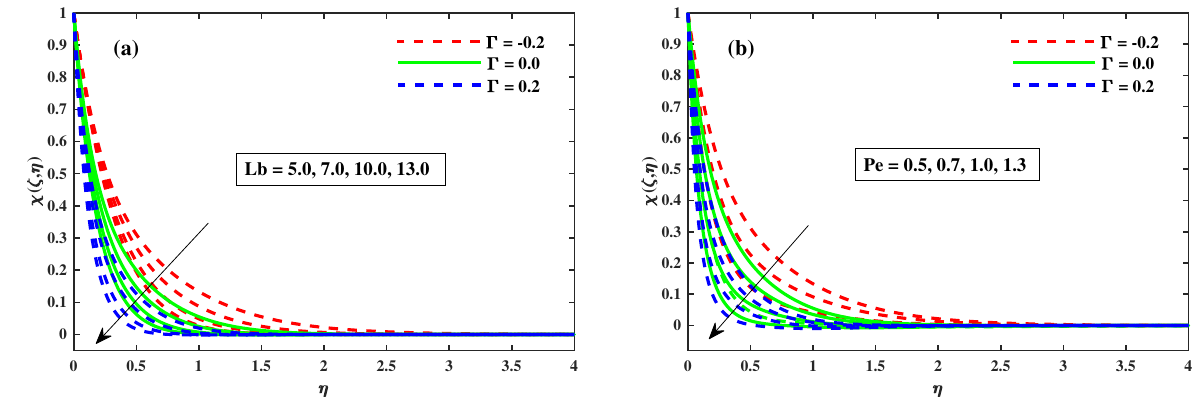
Figure 16. Impact of Lb in ( a ) and Pe in ( b ) on χ ( ζ , η ) at ζ = 1.